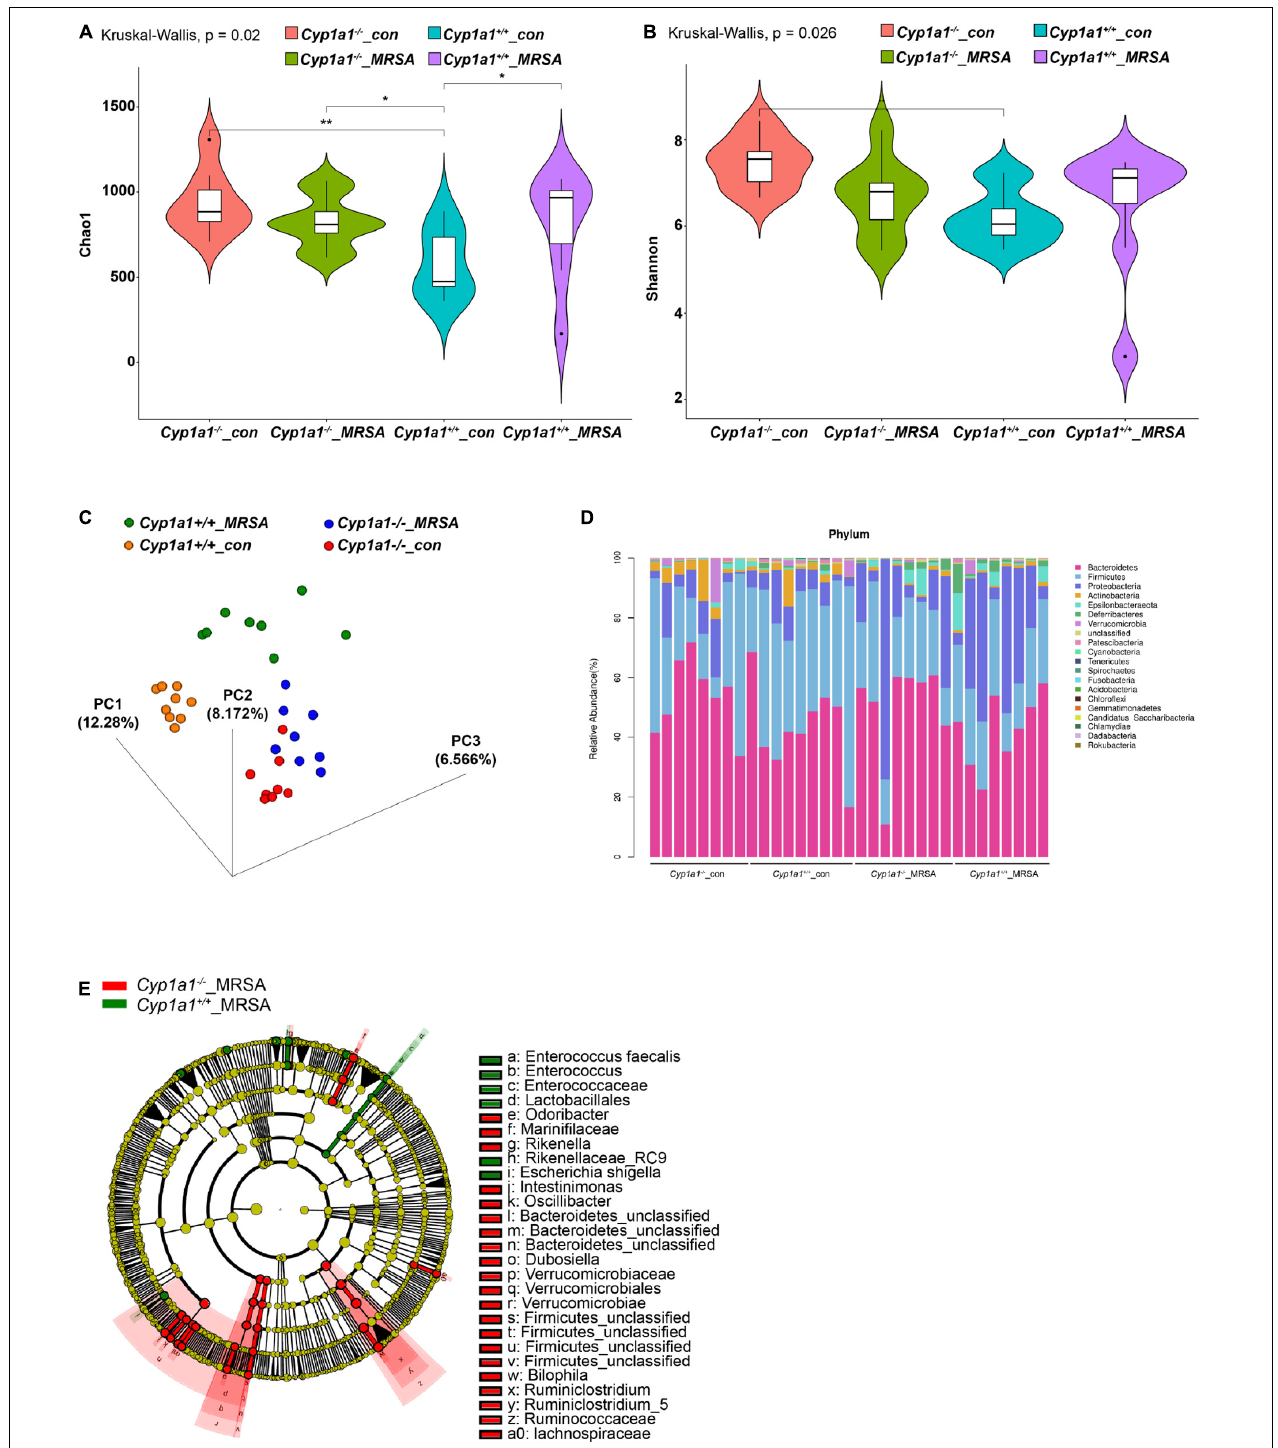
FIGURE 4 | Cyp1a1 deficiency alters the gut microbiota composition. (A) Chao 1 index and (B) Shannon index measuring bacterial richness and diversity by 16S rDNA sequencing in the caecal content of Cyp1a1 + / + mice and Cyp1a1 − / − mice with or without MRSA infection ( n = 8–9). (C) The unweighted UniFrac-based 3D-PCoA showed obvious differences in the gut microbiota composition between mice in (A) ( n = 8–9). (D) Bar chart of the relative microbiome abundance at the phylum level from mice as in (A) . (E) The cladogram based on LEfSe analysis shows bacterial taxa (class, order, family, and genus) differentially abundant in Cyp1a1 + / + mice and Cyp1a1 − / − mice with MRSA infection. Green indicates increased abundance in the Cyp1a1 + / + _MRSA group; red indicates increased abundance in the Cyp1a1 − / − _MRSA group. * P < 0.05, ** P < 0.01.